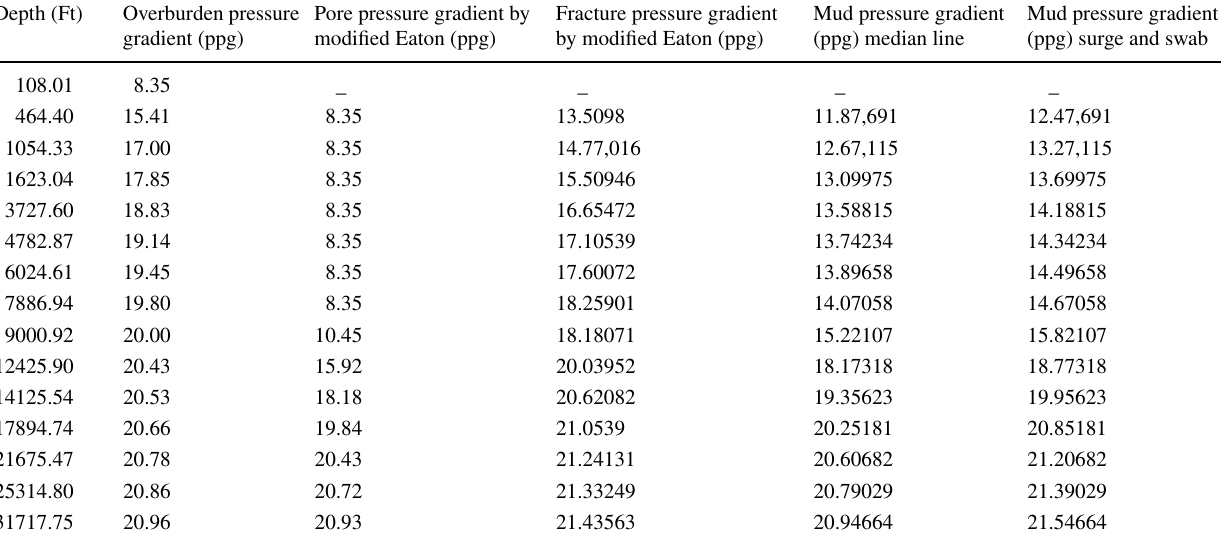
Table 11 Optimum mud weight by median line principle on the top of The Tulamura